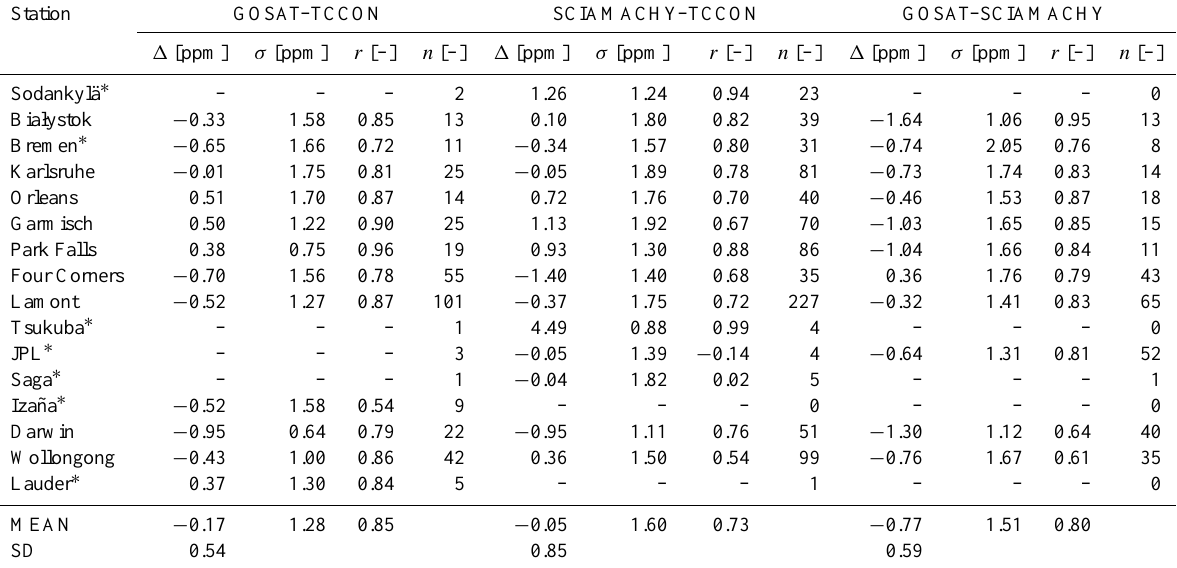
Table 7. Results of the comparison of daily averages of (standard) GOSAT, SCIAMACHY and TCCON XCO 2 for 2010–2011 (see Fig. S3 for time series). The values are computed as for Table 6. Here, the comparisons at the TCCON sites marked with a ∗ , with less than 10days of data for all three comparisons, should be interpreted with care. The mean offset (mean of the mean differences), the estimated single measurement precision (mean of the standard deviation of the difference), the mean correlation coefficient and the station-to-station bias (standard deviation of the mean differences) are calculated without these